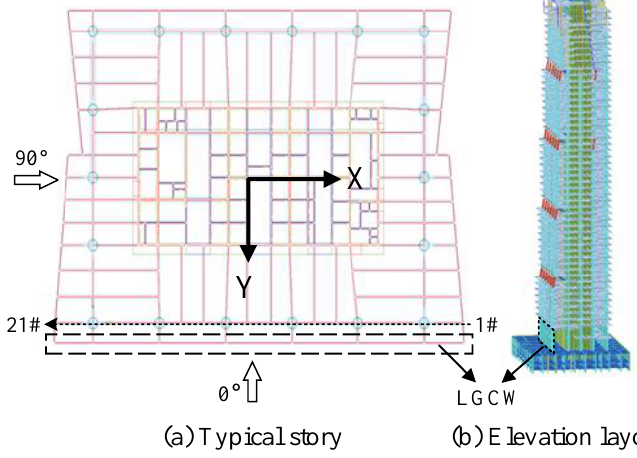
Figure 1. The structural layout and wind direction. A simplified FE model of the independent LGCW is established in ANSYS according to the structural design parameters. SHELL 63 is used to simulate glass panels, silicone adhesive, and columns, and BEAM 44 is used to simulate crossbeams. The independent LGCW employs the hollow double-layer glass panels, the inner and outer glass panels (SHELL 63) are connected with the silicone adhesive (SHELL 63), and the inner glass panels are connected to steel columns (SHELL 63) with the silicone adhesive. Figure 2 displays the connection joint of the independent LGCW and the corresponding simplified FE model.